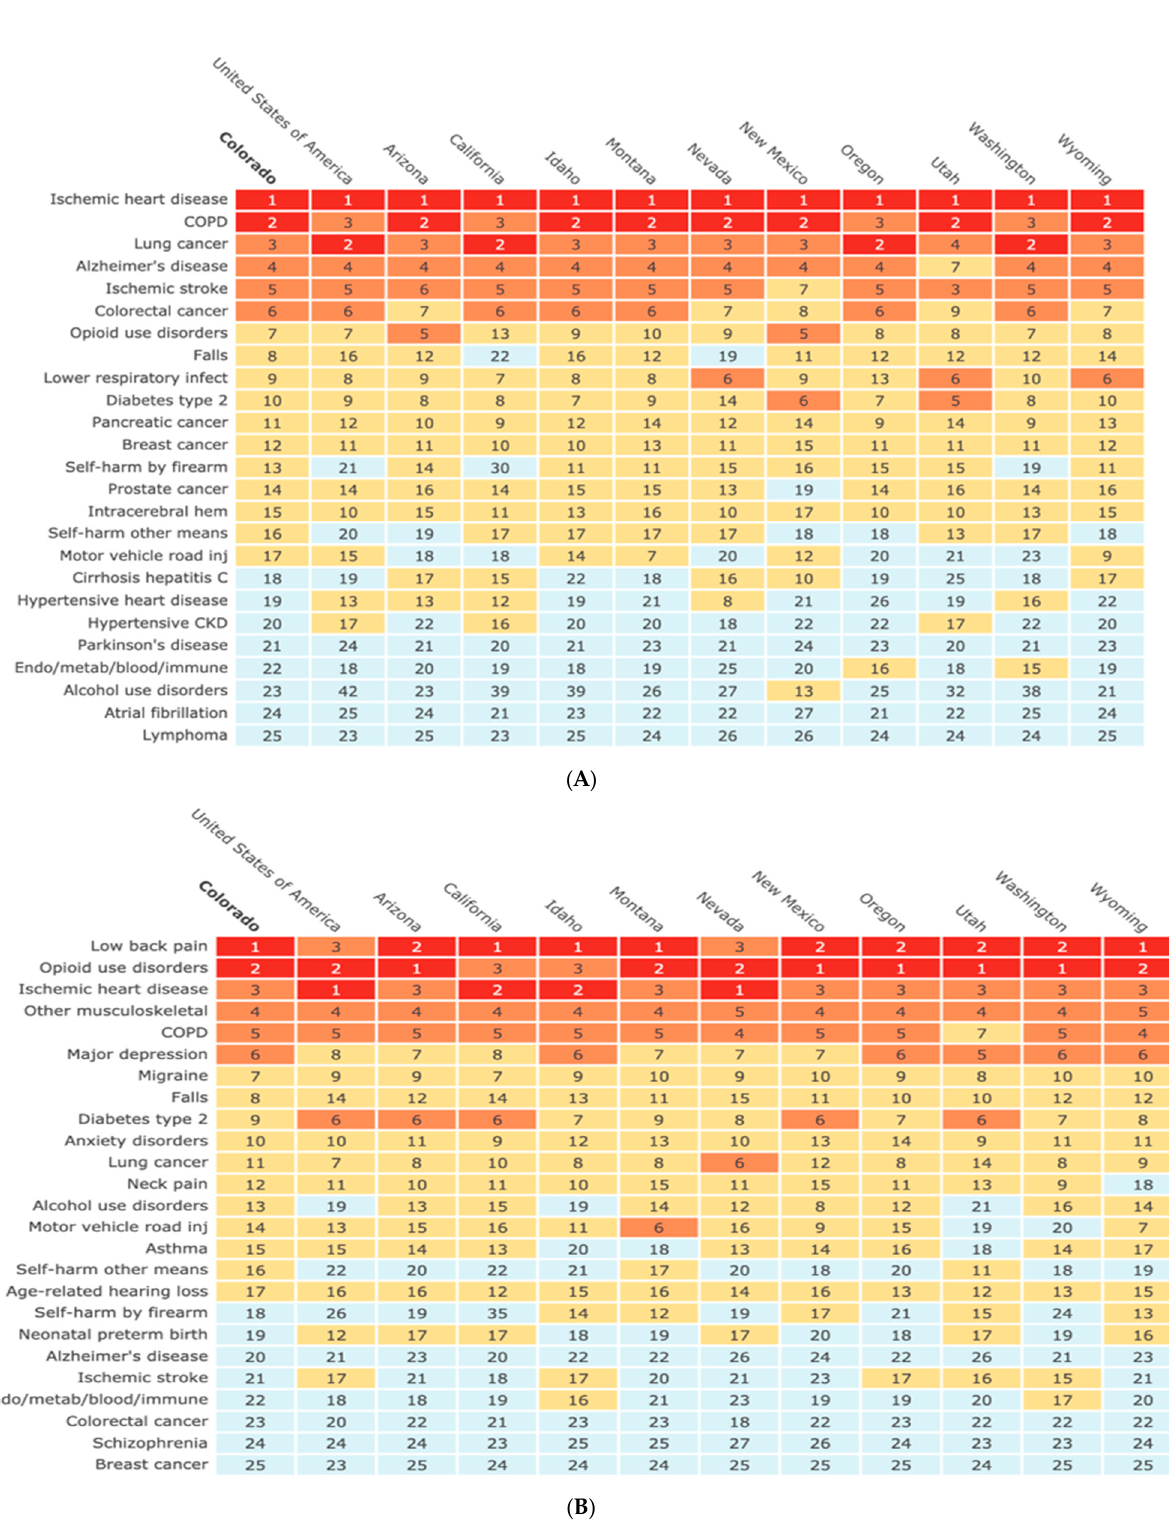
Figure 2. Top ‐ ranked causes of ( A ) death and ( B ) disability ‐ adjusted life years (DALYs) per 100,000, Level 4, age ‐ standardized, in Colorado, West Census States, and the United States, for both sexes, 2019. Numbers are rankings, with colors indicating the scale from low (blue: below 17th) to high (red: first and second) rankings. Institute for Health Metrics and Evaluation (IHME). GBD Compare Data Visualization. Seattle, WA: IHME, University of Washington, 2020. Available from http://vizhub.healthdata.org/gbd ‐ compare (accessed on 23 September 2021).